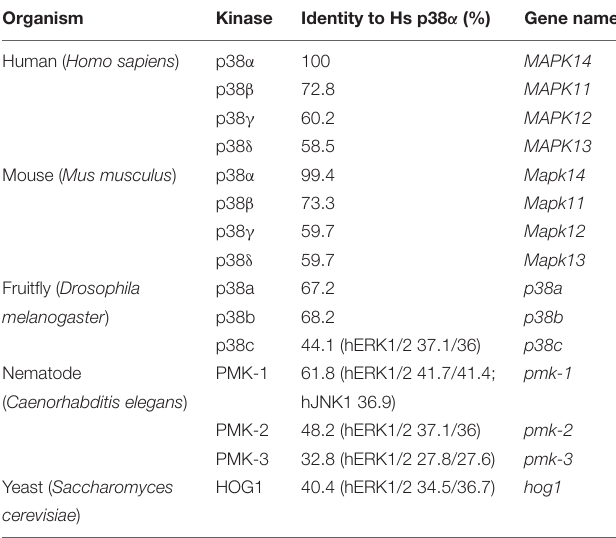
TABLE 1 | p38 homologs in different model organisms and their sequence identity to human p38 α . Organism Kinase Identity to Hs p38 α